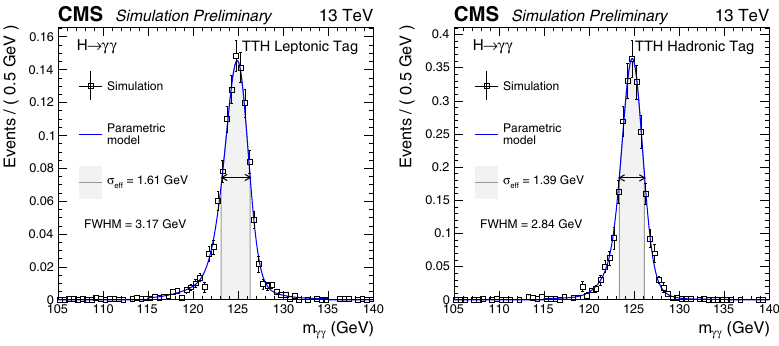
Figure 7. Parametrized signal shapes for the t¯tH category, for a simulated H → γγ signal sample with m H = 125GeV [6]. The black points represent weighted simulation events and the blue lines are the corresponding models. Also shown are the σ e ff value (half the width of the narrowest interval containing 68.3% of the invariant mass distribution), FWHM and the corresponding